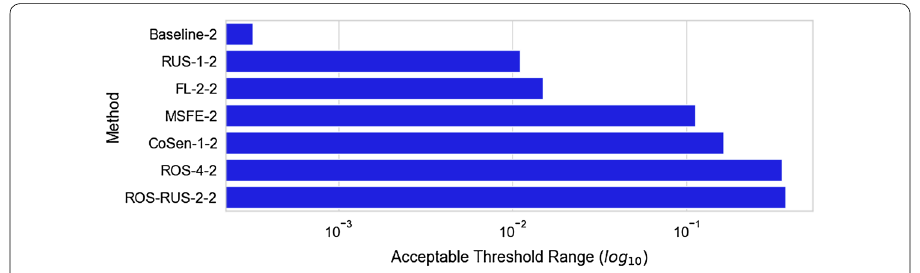
Fig. 3 Average decision threshold intervals (30